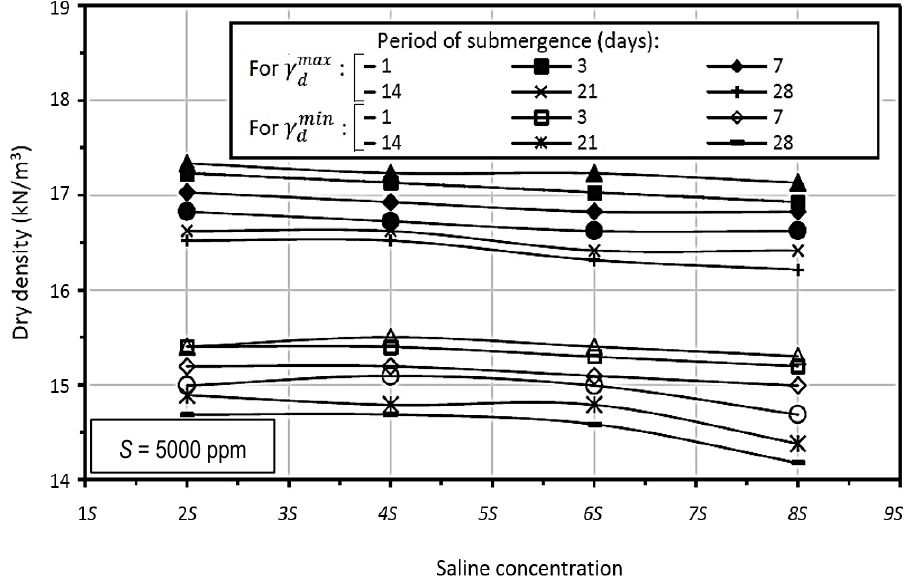
Figure 8. Variation of percentage increase in dry densities with period of submergence. Figure 9 portrays the variation of normalized dry densities with saline concentration.